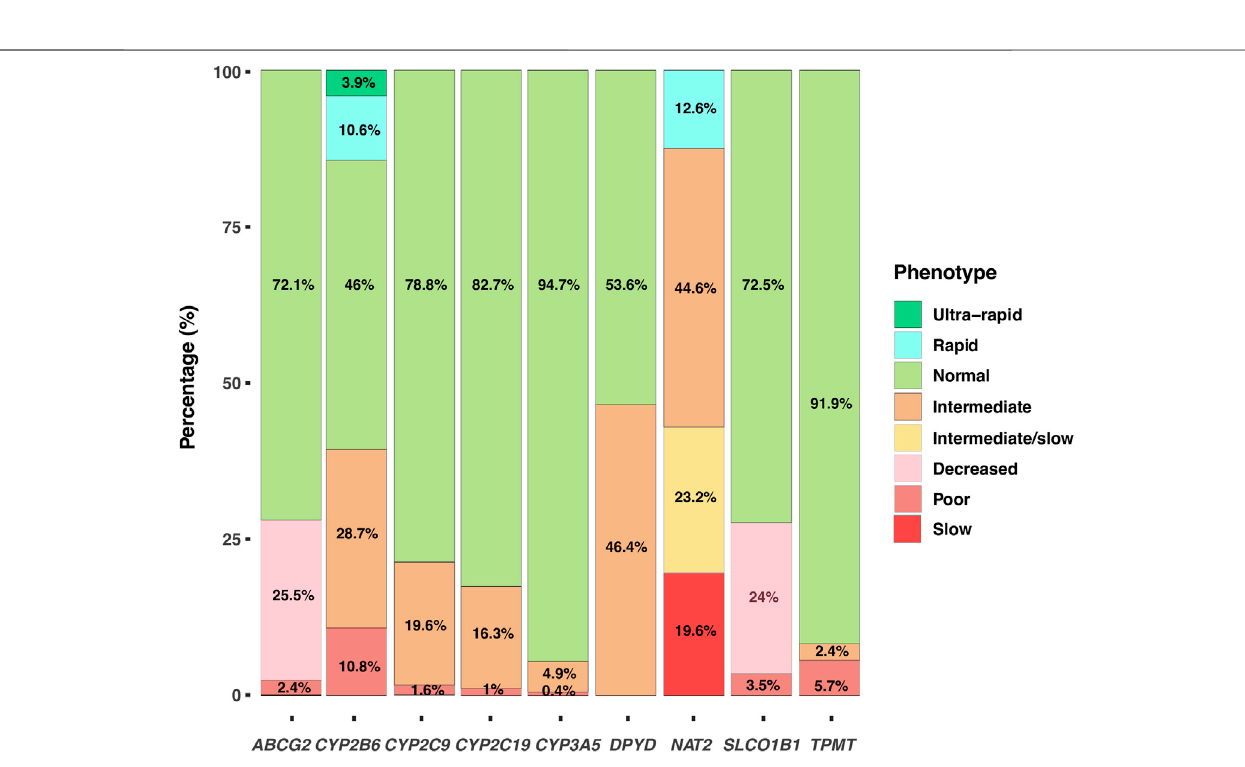
Frontiers in Pharmacology |